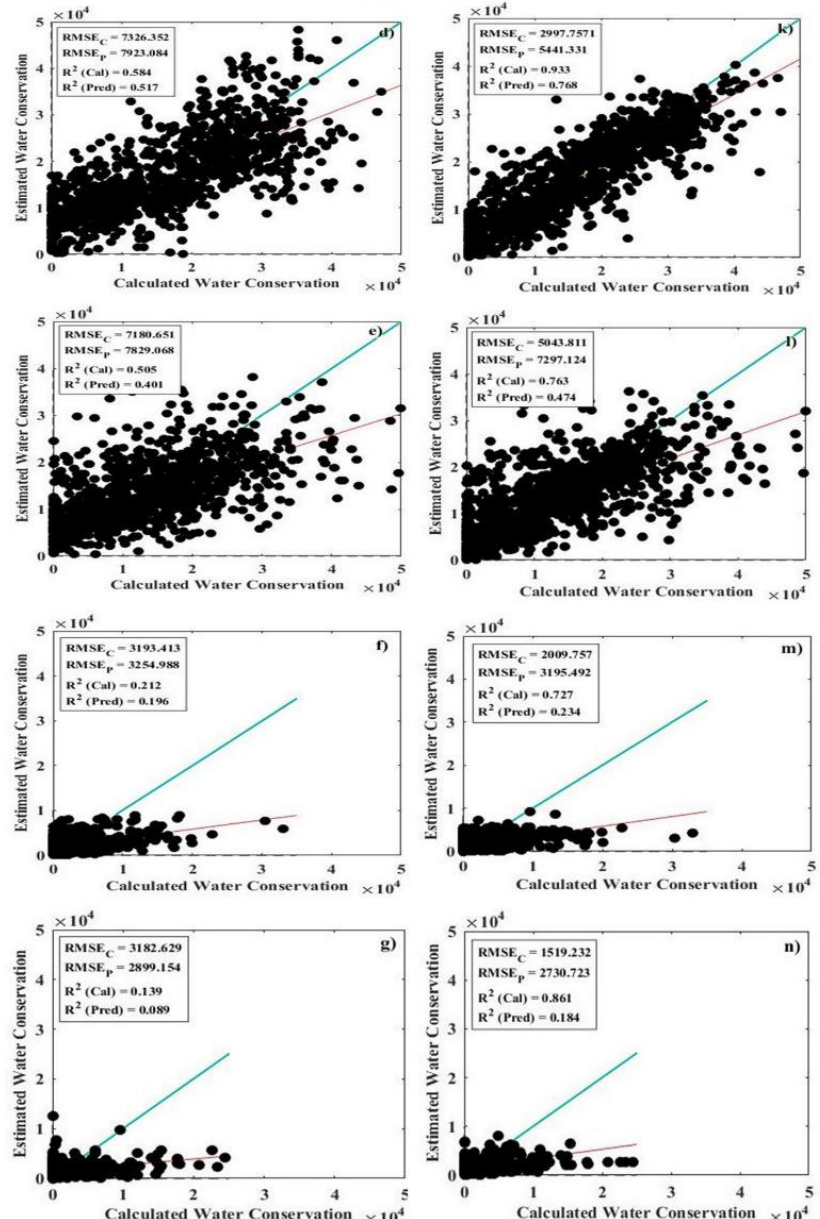
Figure 8. Scatter plots of the calculated and prediction values by the PLSR (partial least squares regression) and SVM (support vector machine) models using stratified data. Note: ( a – g ) represent the farmland, forest, grassland, water/wetland, desert, settlement, and other ecosystems, respectively by PLSR; ( h – n ) represent these seven ecosystems by the SVM. RMSE C , root mean square error of the calculated model, R 2 C , coefficient of determination for the calculated model, RMSE P , root mean square error of the predicted results, and R 2 P , coefficient of determination for the predicted results. The blue and red lines are 1:1 and the fitted lines,